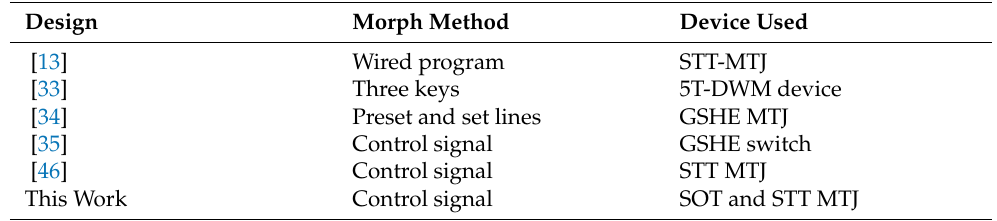
Table 4. Different PGs utilizing spintronics